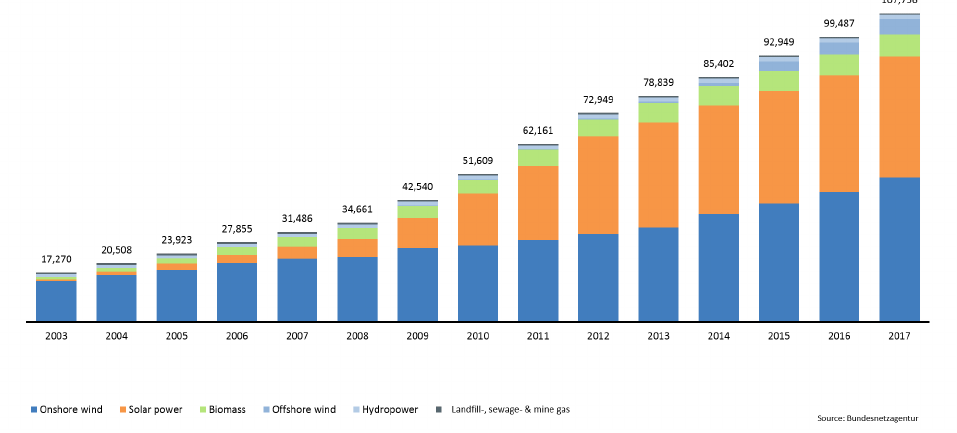
Figure 1. Development of installed RES capacity by source, 2003–2017 (in MW). Source: